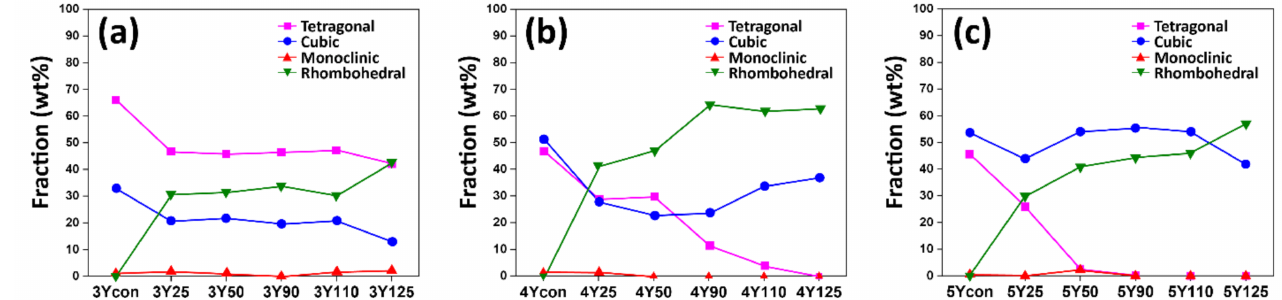
Figure 5. Values of the phase fraction (as weight percent) determined by Rietveld analysis of the XRD patterns for ( a ) 3Y subgroups, ( b ) 4Y subgroups, and ( c ) 5Y subgroups. The tetragonal phase contents decreased while the rhombohedral phase contents increased as the blasting particle size increased for all zirconia